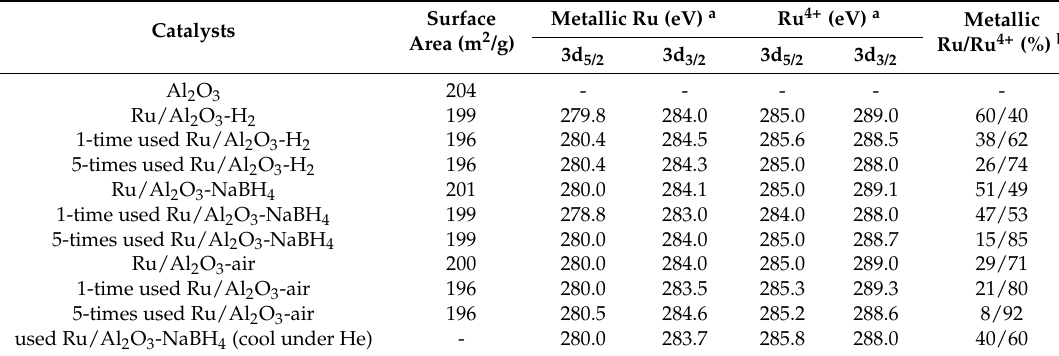
Table 1. Physicochemical properties of the catalysts.